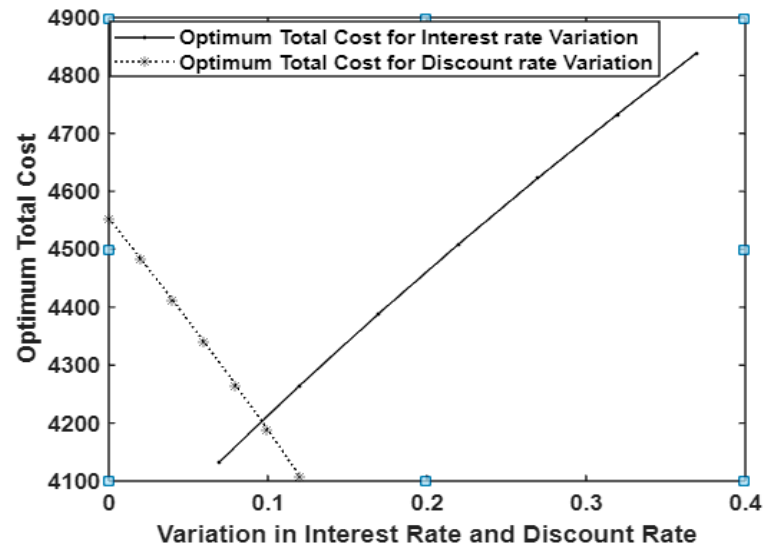
Figure 6. The effect of changes in the interest rate ℐ 𝒫 and the discount rate 𝜉 on arriving at optimal total cost.